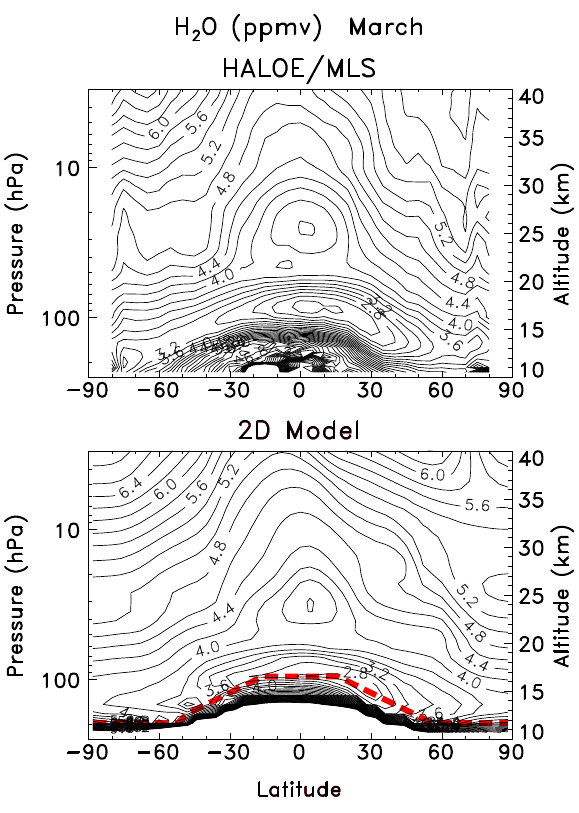
Figure B8. Equatorial profiles of the amplitude and phase lag of the seasonal cyle in the quantity H 2 O+ 2CH 4 from UARS/HALOE (black asterisks) and the 2-D model (red). Amplitudes are relative to the values at 16.5km, and the phase lag is defined to be zero at 16.5km. Values are averaged over 1994– 2004 for both the data and model.